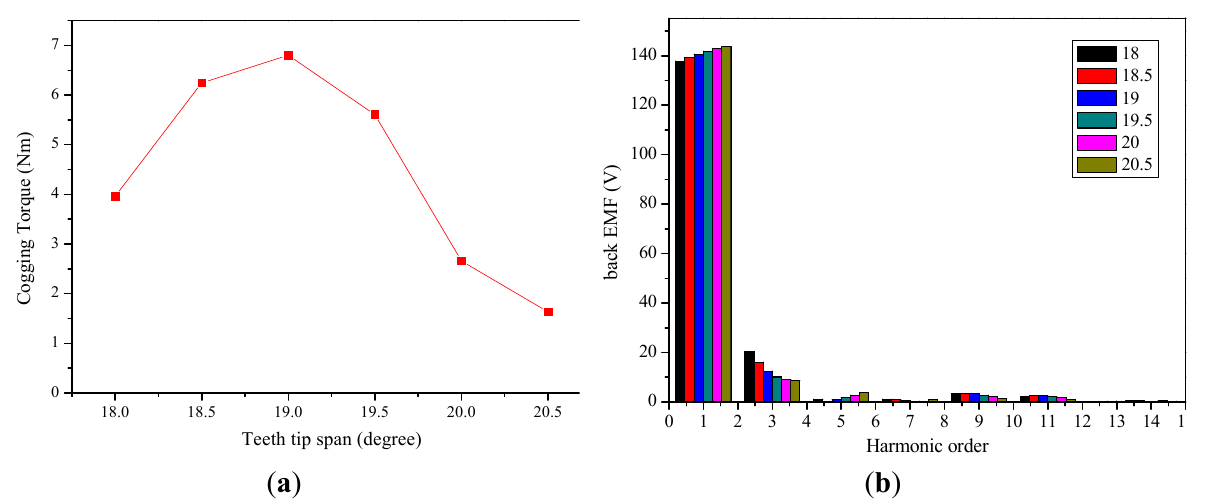
Figure 13. Performance varies with different span of coil-wound teeth tip: ( a ) cogging torque; and ( b ) spectrum for the back EMFs in all